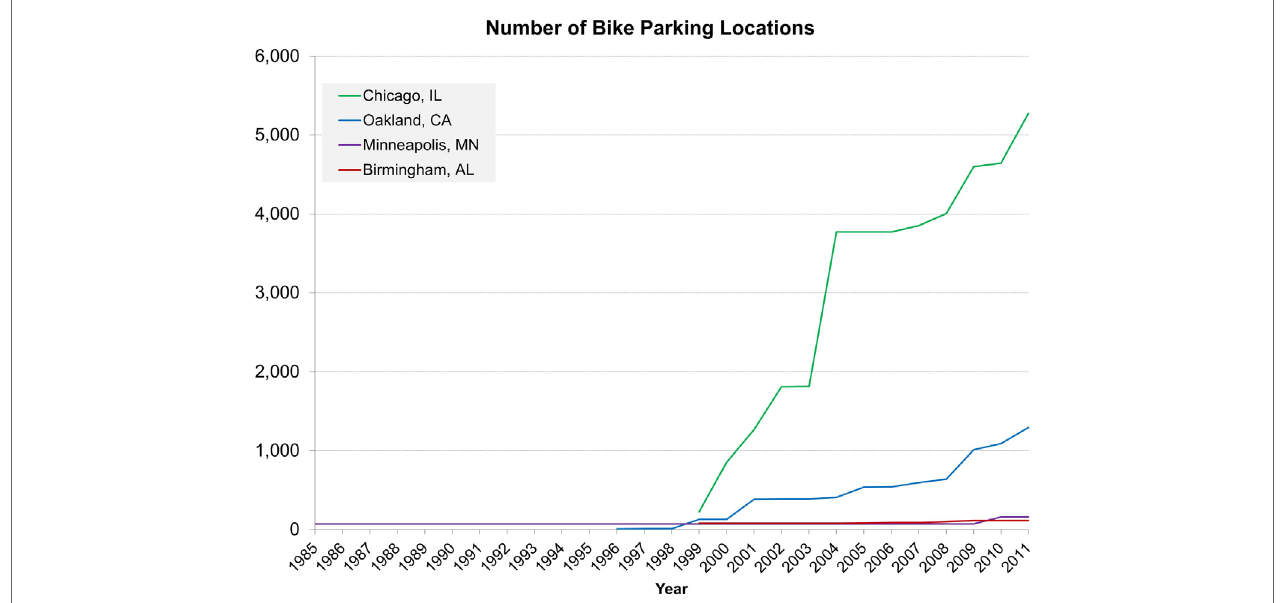
FIGURe 2 | Change in number of bicycle parking locations between 1985 and 2011 by city in the CARdIA four cities field audit . Green represents Chicago, IL, USA; blue represents Oakland, CA, USA; purple represents Minneapolis, MN, USA; red represents Birmingham, AL,